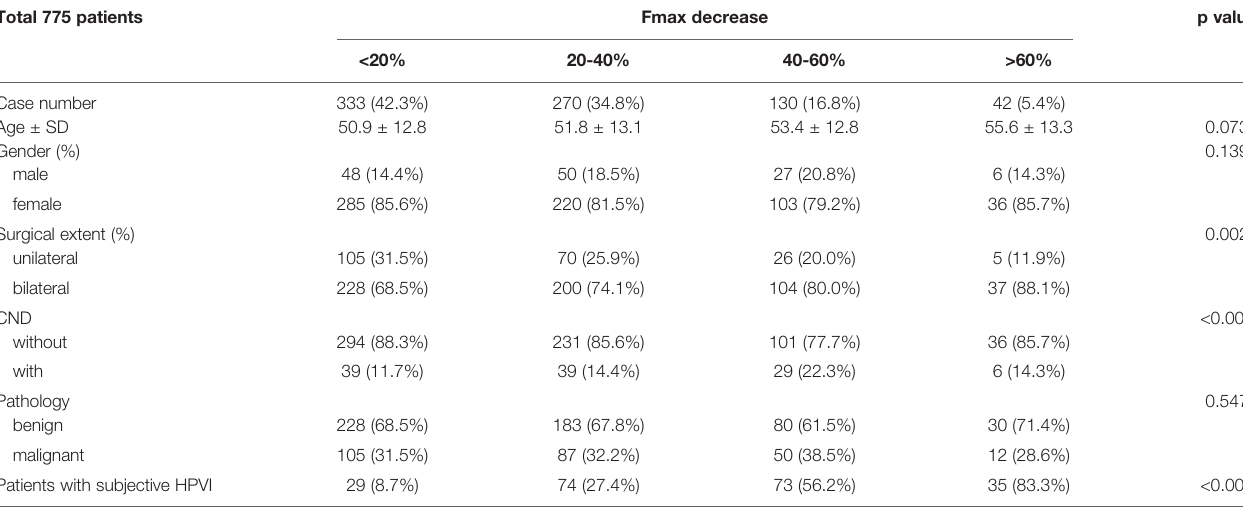
TABLE 2 | Demographic characteristics of patients with different severity of objective high-pitched voice impairment (HPVI).